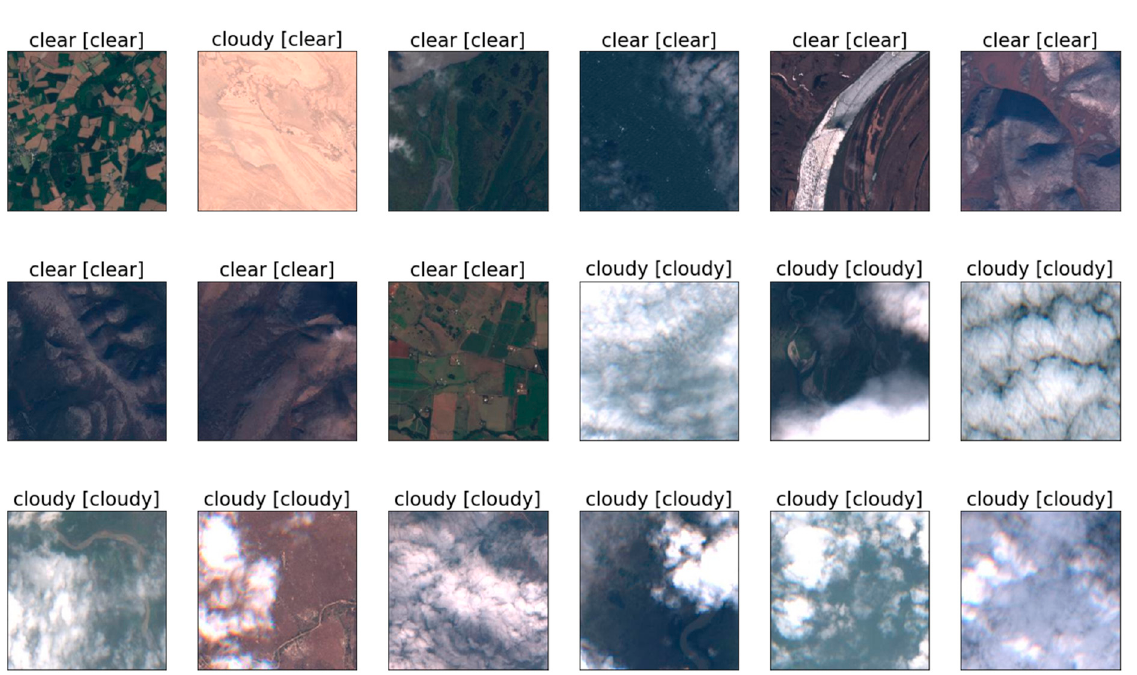
Figure 4. Training and Validation Loss of Image Classifier Model.